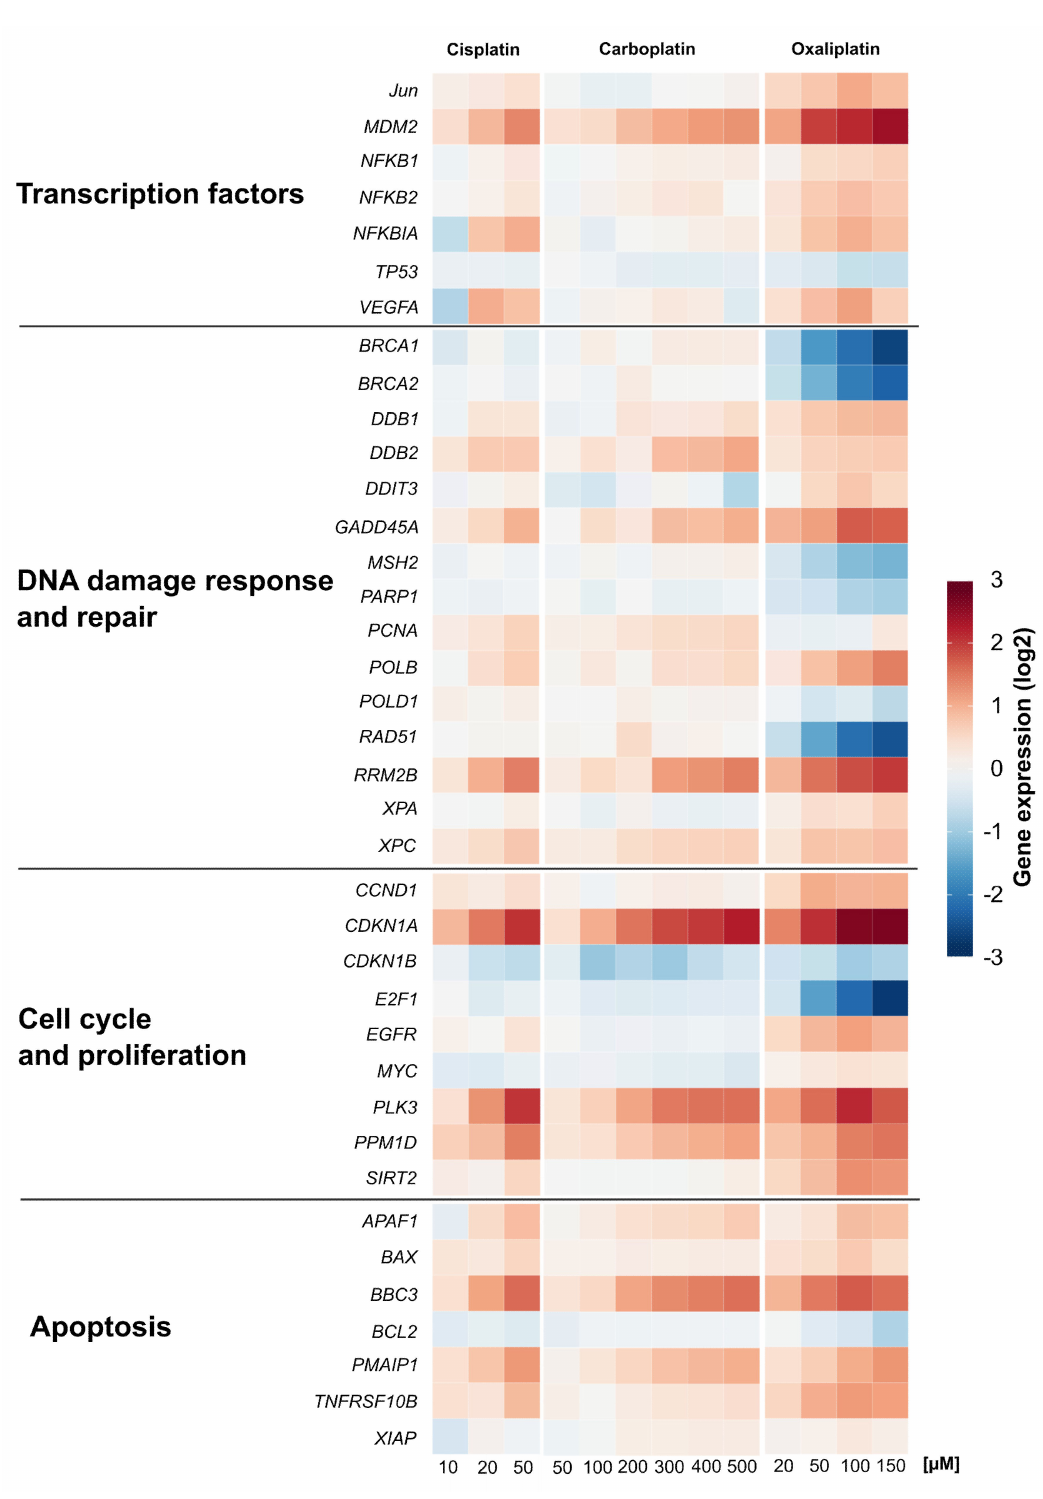
Figure 3. Gene expression profiling of A498 cells after treatment with cisplatin, carboplatin or oxaliplatin. Cells were treated for 1 h with various concentrations of cisplatin (10, 20, 50 µ M), carboplatin (50, 100, 200, 300, 400, 500 µ M) or oxaliplatin (20, 50, 100, 150 µ M) followed by a postcultivation of 24 h. Gene expression was determined by high-throughput RT-qPCR. Genes were grouped into the clusters transcription factors, DNA damage response and repair, cell cycle and proliferation and apoptosis. The log2 mean values are shown for three independent experiments normalized to the untreated control whereby the control equals 0. The data of cisplatin-induced gene expression are taken from